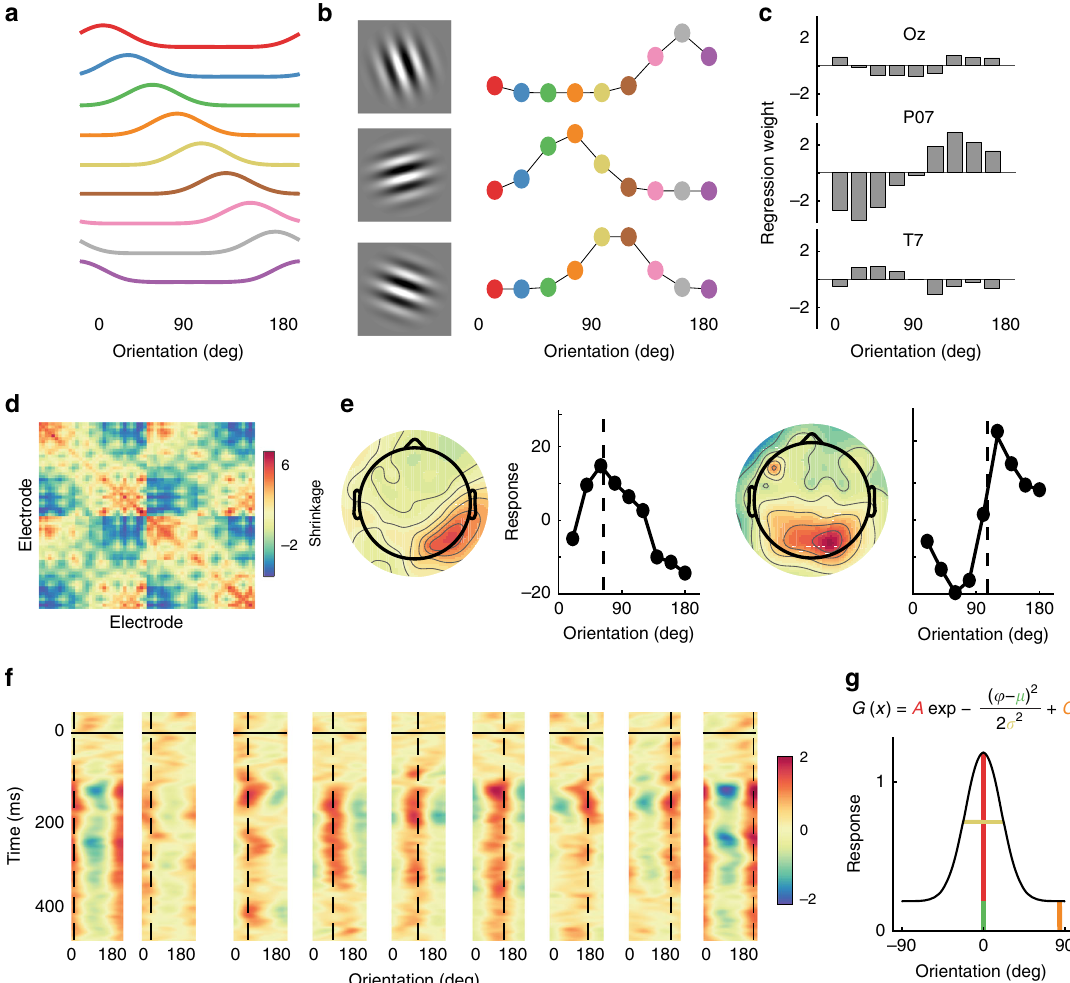
Fig. 9 Schematic illustrating the forward encoding procedure used to estimate feature-selectivity for orientation in Experiment 2. a A basis set of the nine channels used to model feature (orientation) selectivity. b The basis set was used to fi nd the expected response (regression coef fi cients) for each different RSVP item in every trial, for each EEG electrode (three electrodes are shown here for a single example participant). Three trials are shown for the corresponding gratings. c Ordinary least squares regression was used to fi nd regression weights for the orientation channels across trials for each EEG electrode (three electrodes are shown here for a single example participant). d Shrinkage matrix that the weights were divided by to perform regularisation, to account for correlated activity between electrodes. e The regression weights were applied to predict the presented orientation. Neural activity (headmaps) from two trials, with the channel responses for those trials. Dotted lines indicate the presented orientations. f Applying this procedure to each time point gives the time course of feature-(orientation) selectivity (for one participant). Trials have been binned in 20º intervals, with the dotted lines representing the presented orientation in those trials. On the y -axis, 0 ms represents the onset of the item within the RSVP stream. Feature selectivity emerged around 75 ms after stimulus presentation. g Modi fi ed Gaussian functions (equation) were used to quantify the tuning. The colours of the free parameters in the equation correspond to the relevant components of the tuning curve